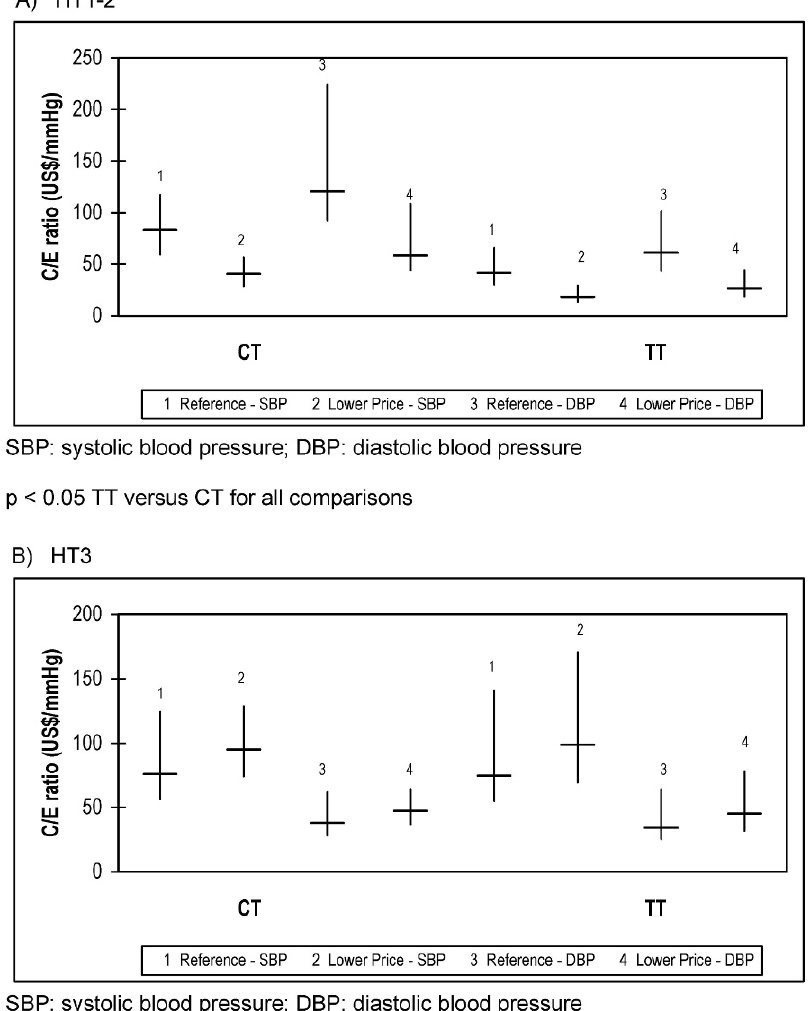
Figure 4 - Comparison of C/E ratios between the brand-name and lower-priced medications according to treatment regimen - current treatment (CT) versus traditional treatment (TT) - in patients with grade 1 or 2 hypertension (HT1-2 – Panel A) or grade 3 hypertension (HT3 – Panel